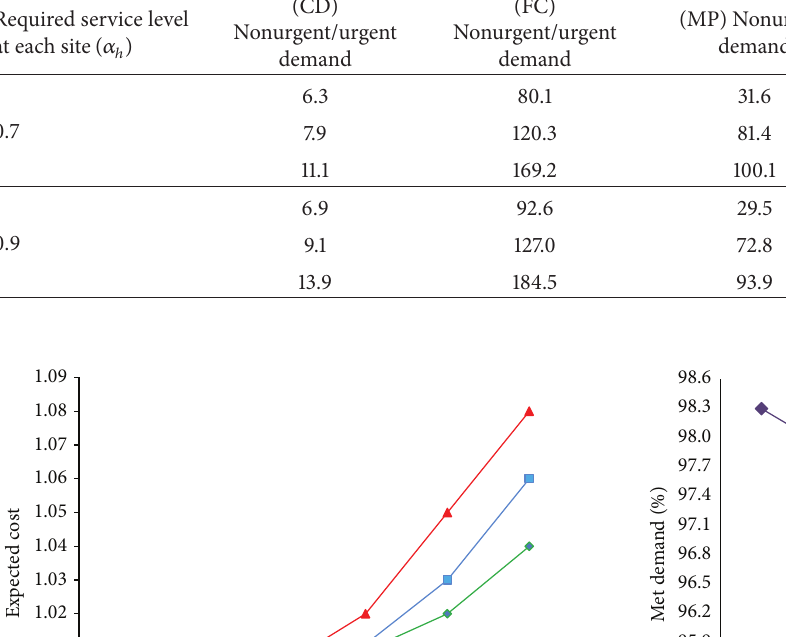
Table 4: Average distance patients travel to receive the service under the different policies (MP, CD, and FC). Required service level